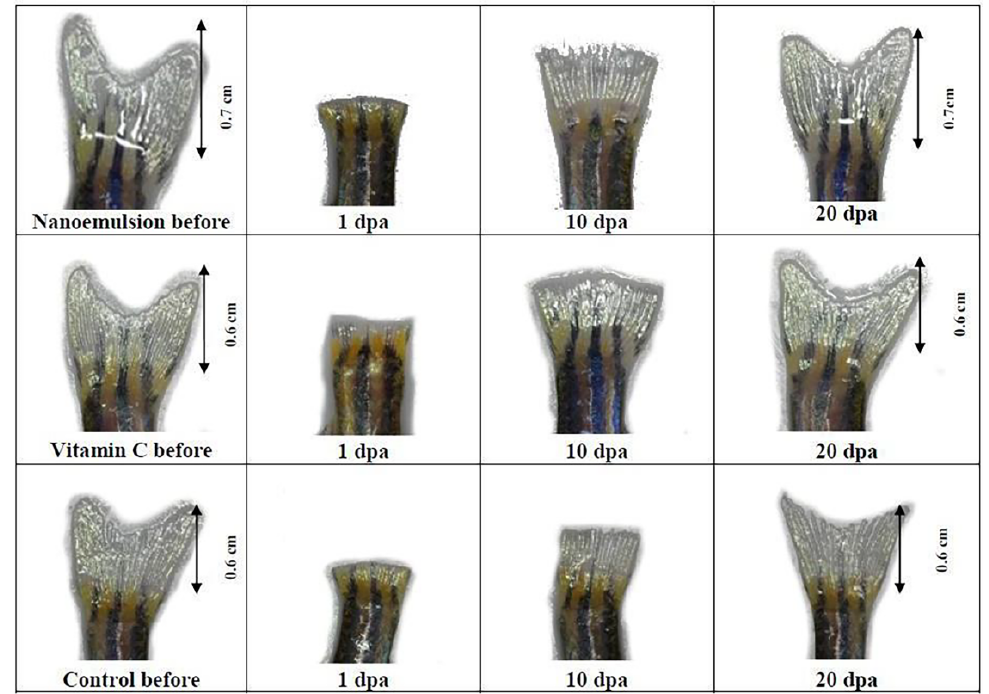
Figure 4. Adult zebrafish tail regeneration before and after treatments (adapted from [17], published by PLOS, 2022). by PLOS,